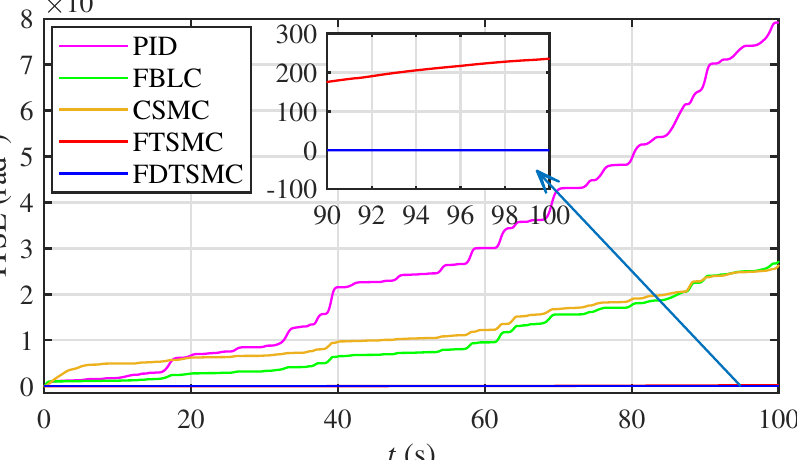
Figure 16. Integral of time squared error.